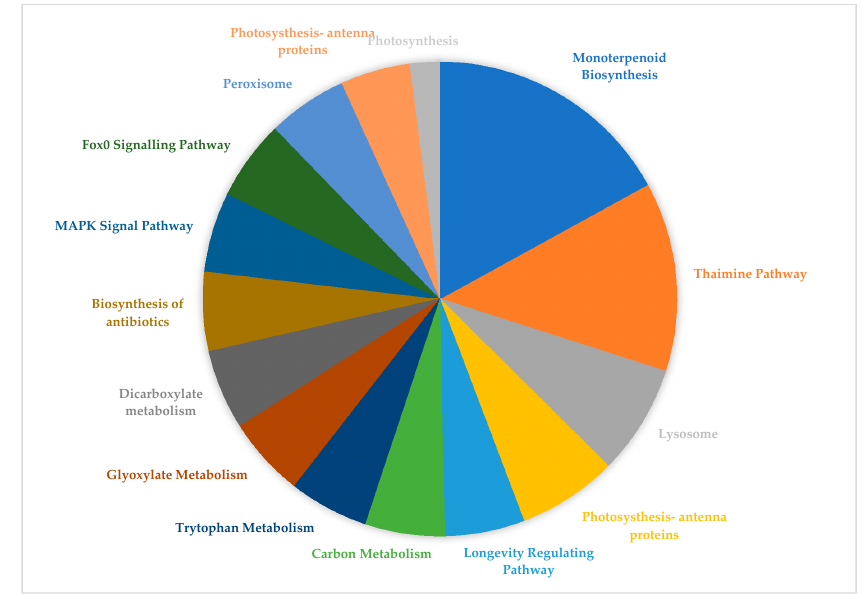
Figure 5. The top 15 pathways in the A. marmelos leaf.